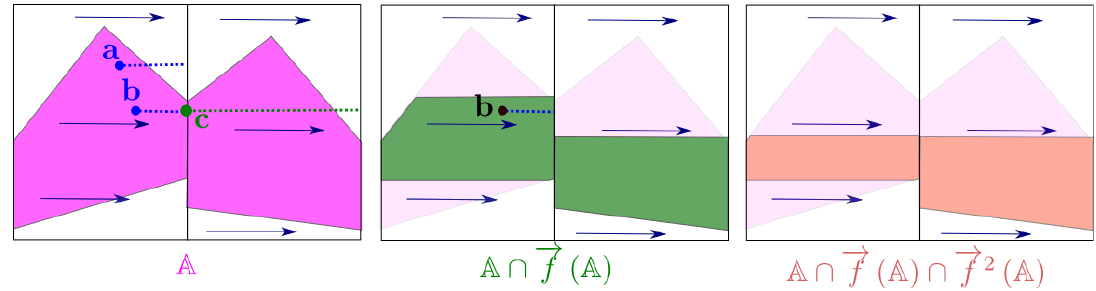
−→ f ( A ) eliminating points that will escape from A